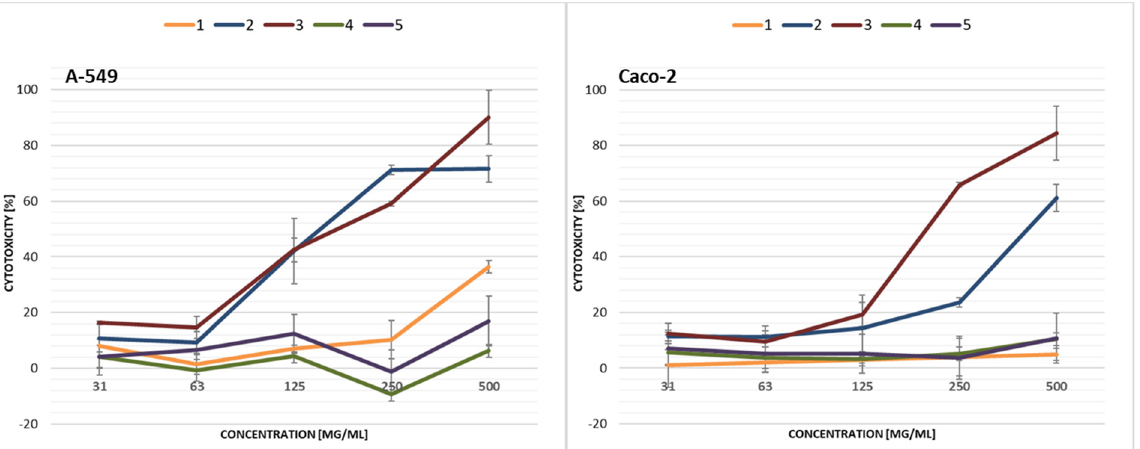
Figure 9. Cytotoxicity of municipal solid waste leachate samples collected from the landfill in the PrestoBlue assay after 72 h exposure of A-549 lung and Caco-2 intestinal epithelial cells. Each data point represents the mean of the fluorescence values from the cells of the four replicates. Results are presented as mean ± SD. Table 3. IC 50 (mg/mL) values of waste leachate samples and soil extracts collected from the landfill against cell lines.